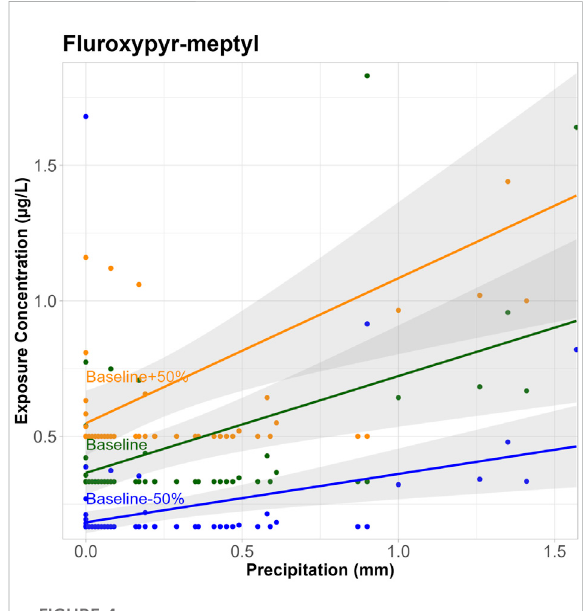
FIGURE 4 Example fl uroxypyr-meptyl exposure concentration